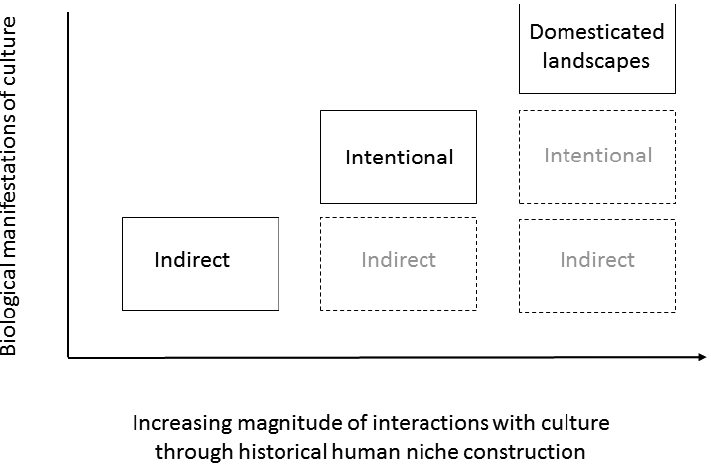
Figure 1. Biological cultural heritage defined as biological manifestations of culture, reflecting indirect or intentional effects or domesticated landscapes, resulting from historical human niche